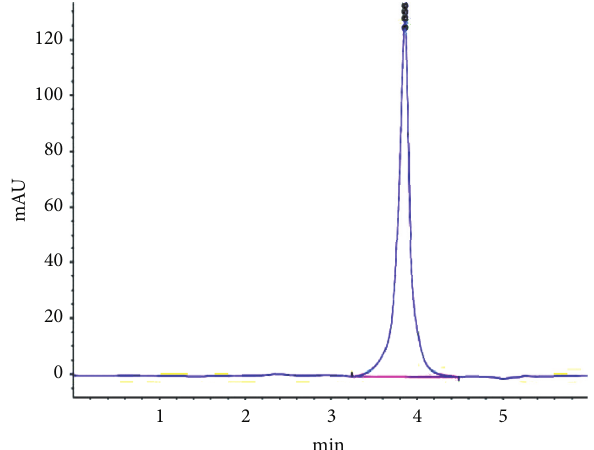
Figure 3: Representative chromatogram for analysis of ethambutol hydrochloride 100mg tablet batches.